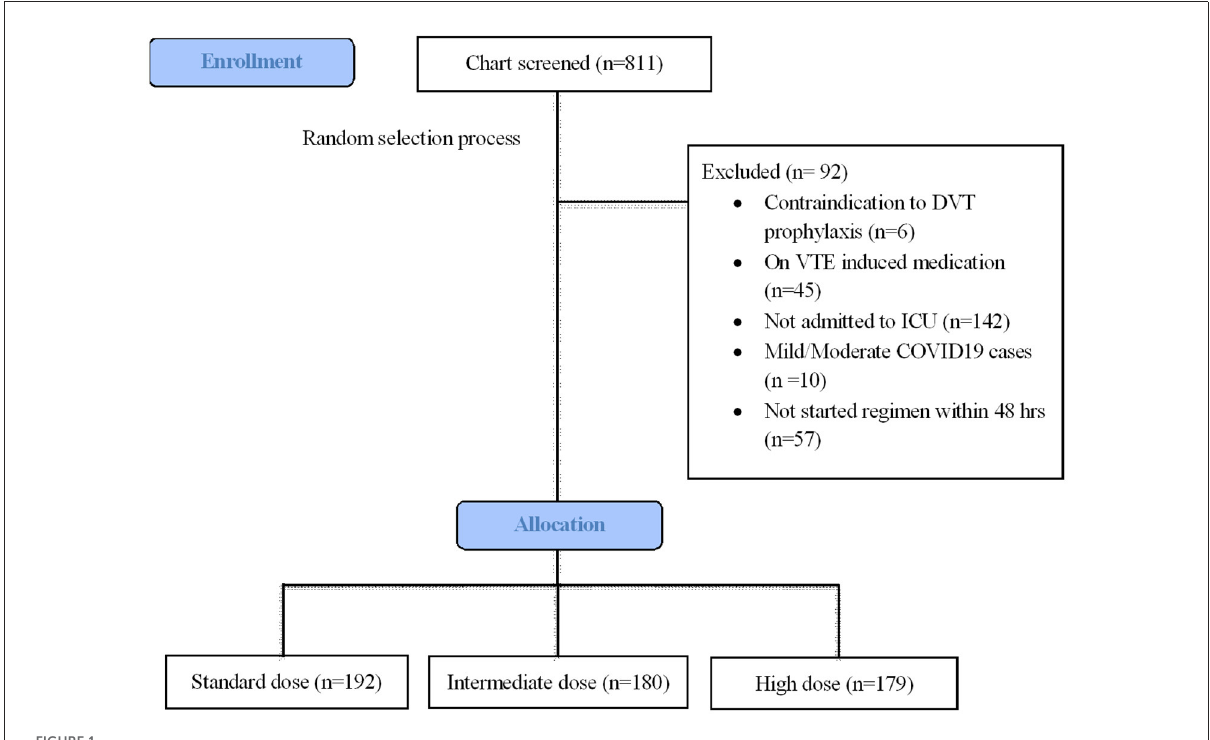
FIGURE1 Patients selection